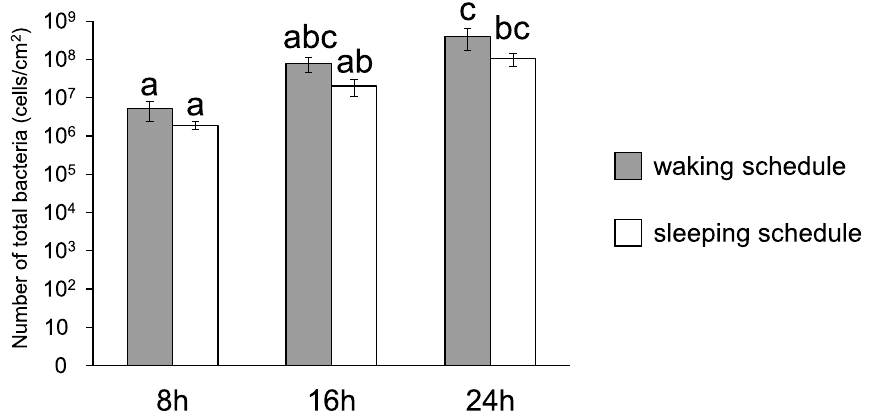
Figure 4. Numbers of total biofilm-forming bacteria. Numbers of total biofilm-forming bacteria over time in dental biofilms from the waking and sleeping schedules, as measured by real-time PCR. Significant differences are represented by different letters (Friedman’s test at p <